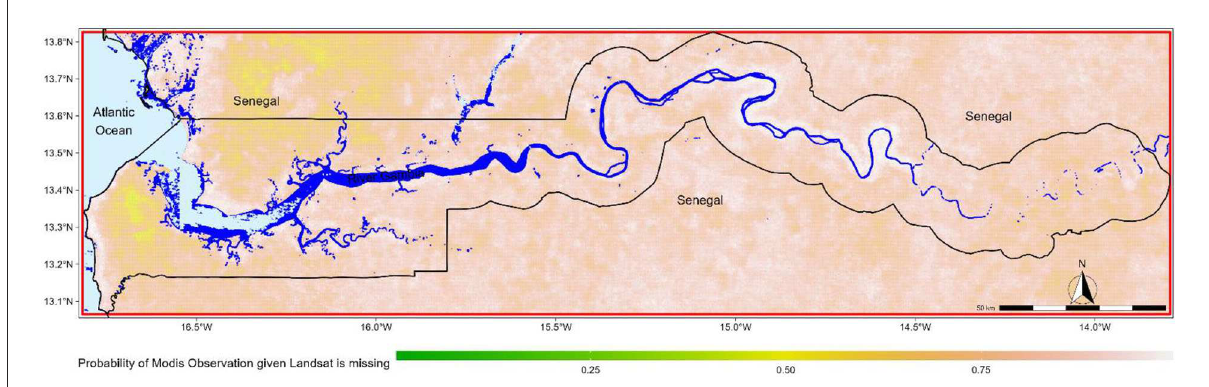
FIGURE1 Overview of The Gambia. The red box indicates the bounding box of the country used as a reference for data collection in a spatial analysis of mangrove forests in The Gambia. Fresh water bodies are represented in darker blue color and salty water in lighter blue color. The probability of MODIS observation given the Landsat is missing is estimated using the Bayes rules of conditional probability; the 2 events being Landsat observation are missing and MODIS observation is available at a given pixel. The estimated probability is based on all remote sensing artifacts, as identified by Fmask and MODLAND QA, in Landsat and MODIS images acquired between 1999 and